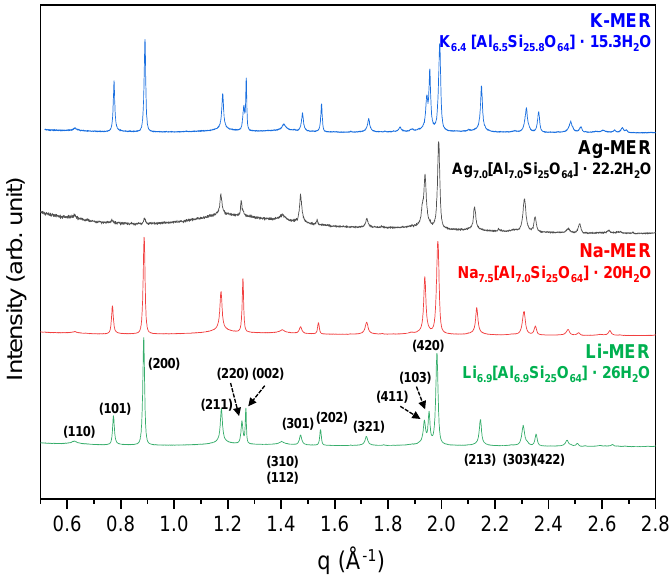
Figure 1. Changes in the synchrotron X-ray powder diffraction patterns of Li-, Na-, Ag-, and K-MER at ambient conditions. Miller indices are shown for the Bragg peaks. Chemical compositions are derived from our refinement results.